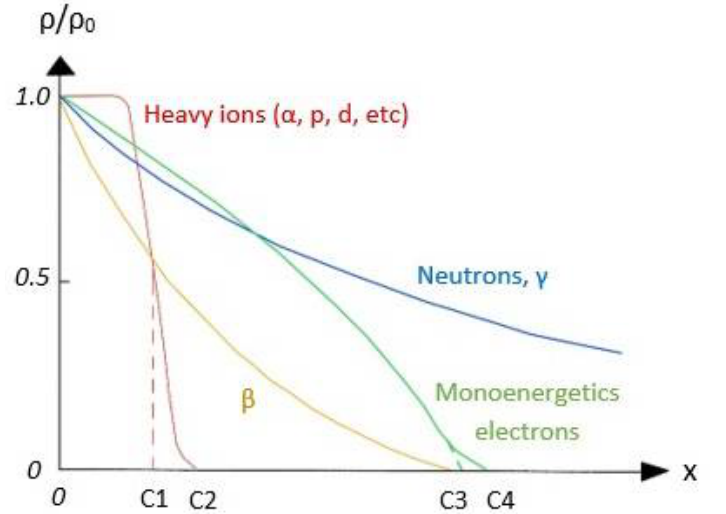
Figure 2. Curves showing relative transmission ρ/ρ0 as function of absorber thickness x. C1 and C3 are average, C2 and C4 are the maximum range. Reprinted from: Choppin G, Liljenzin J, Rydberg J. CHAPTER 6 Absorption of Nuclear Radiation, Radiochemistry and Nuclear Chemistry, Copyright (2002) with permission from Elsevier.